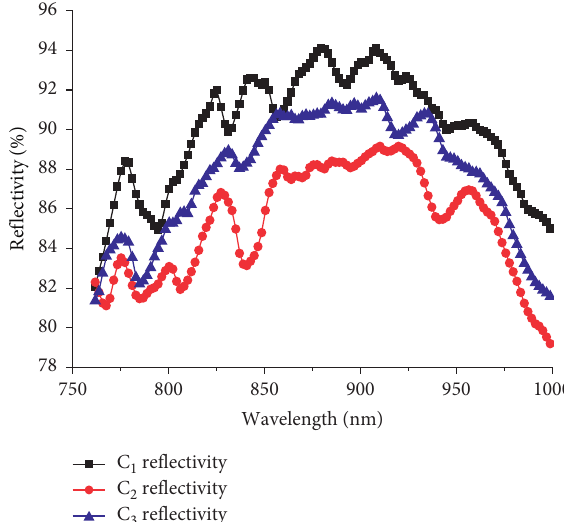
Figure 12: Infrared reflectance of the hollow